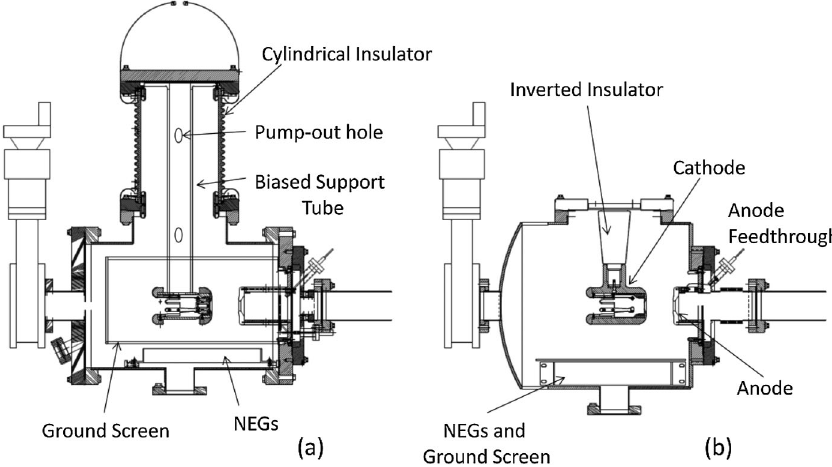
FIG. 1. Diagrams of the two recent gun designs: (a) conventional large-bore cylindrical insulator and (b) inverted gun with compact tapered insulator that extends into the gun vacuum vessel. Both drawings have the same scale with top flanges 10 00 diameter. The cathode/anode gap is (cid:1) 6 cm for both